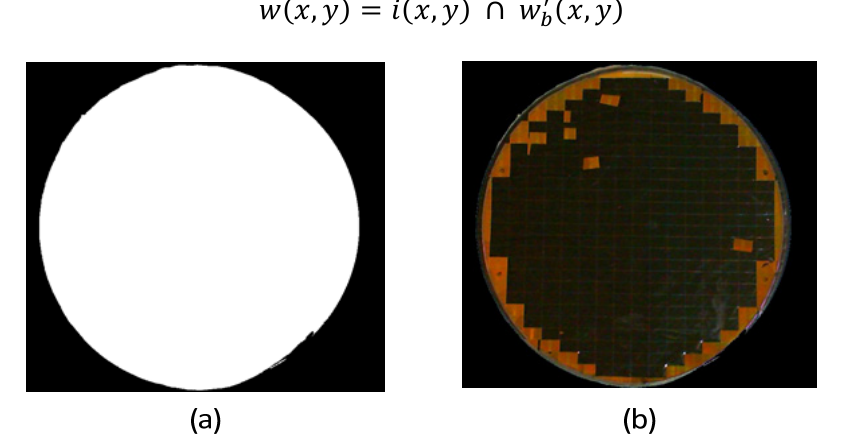
Figure 3. ( a ) The mask of capturing the wafer image; ( b ) Wafer image with black